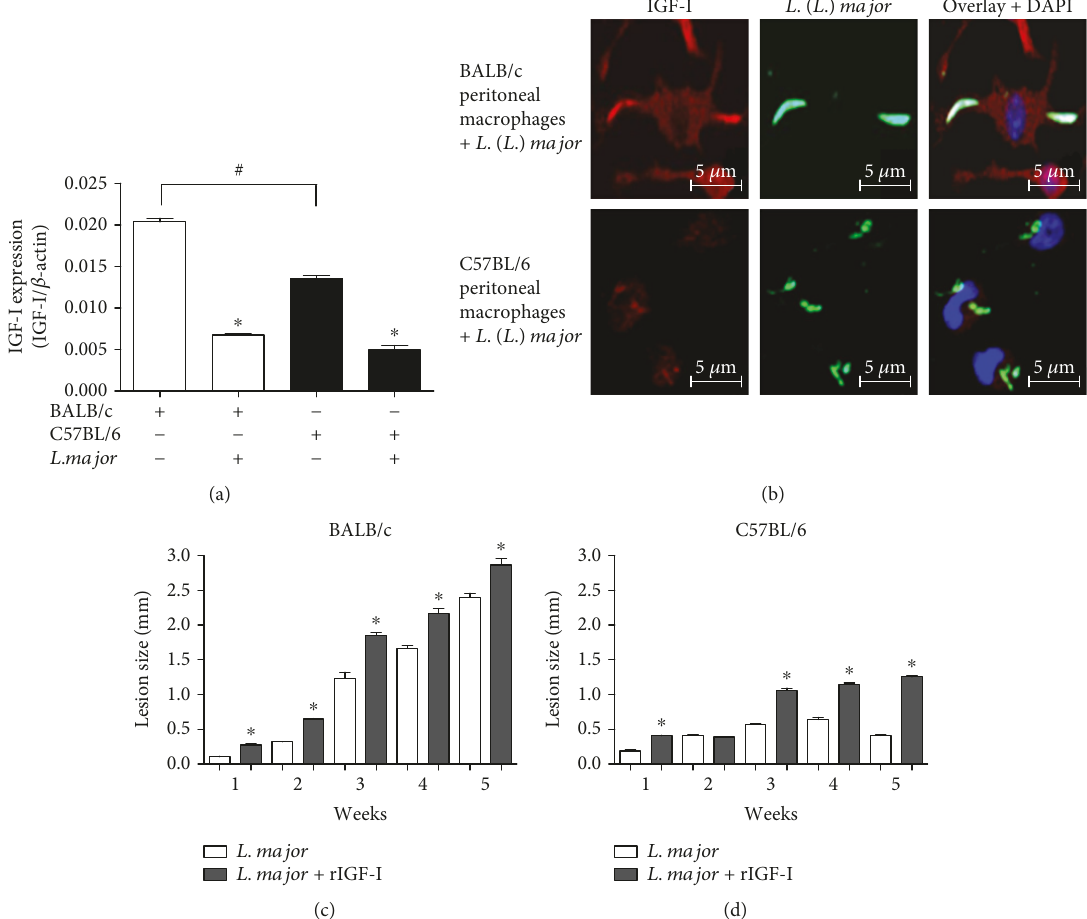
Figure 8: IGF-I expression and the e ff ect of IGF-I on lesion development in L. major -susceptible and -resistant mouse strains . (a) The ratio of the Igf-I mRNA amount to β -actin mRNA amount in L. major -infected BALB/c (white bars) and C57BL/6 peritoneal macrophages (black bars) is shown. (b) Confocal microscopy was used to detect IGF-I expression via immunostaining with a 1 :75 dilution of an anti-IGF-I antibody (using an Alexa Fluor 546-conjugated secondary antibody; red) and a 1:200 dilution of an anti- Leishmania antibody (using an Alexa Fluor 488-conjugated secondary antibody; green). DAPI (blue) was used to stain the nuclei. Images were captured using a confocal Leica LSM510 microscope with a 63x oil immersion objective. (c and d) Stationary-phase promastigotes (10 6 ) that were preincubated with or without recombinant IGF-I (50 ng/mL) for 5min were injected into the footpads of BALB/c and C57BL/6 mice, and lesion development was measured for six weeks. One representative experiment from three independent assays is shown. ∗ P < 0 05 (ANOVA and Tukey ’ s tests) compared to the respective controls. # P < 0 05 (ANOVA and Tukey ’ s tests) between BALB/c and